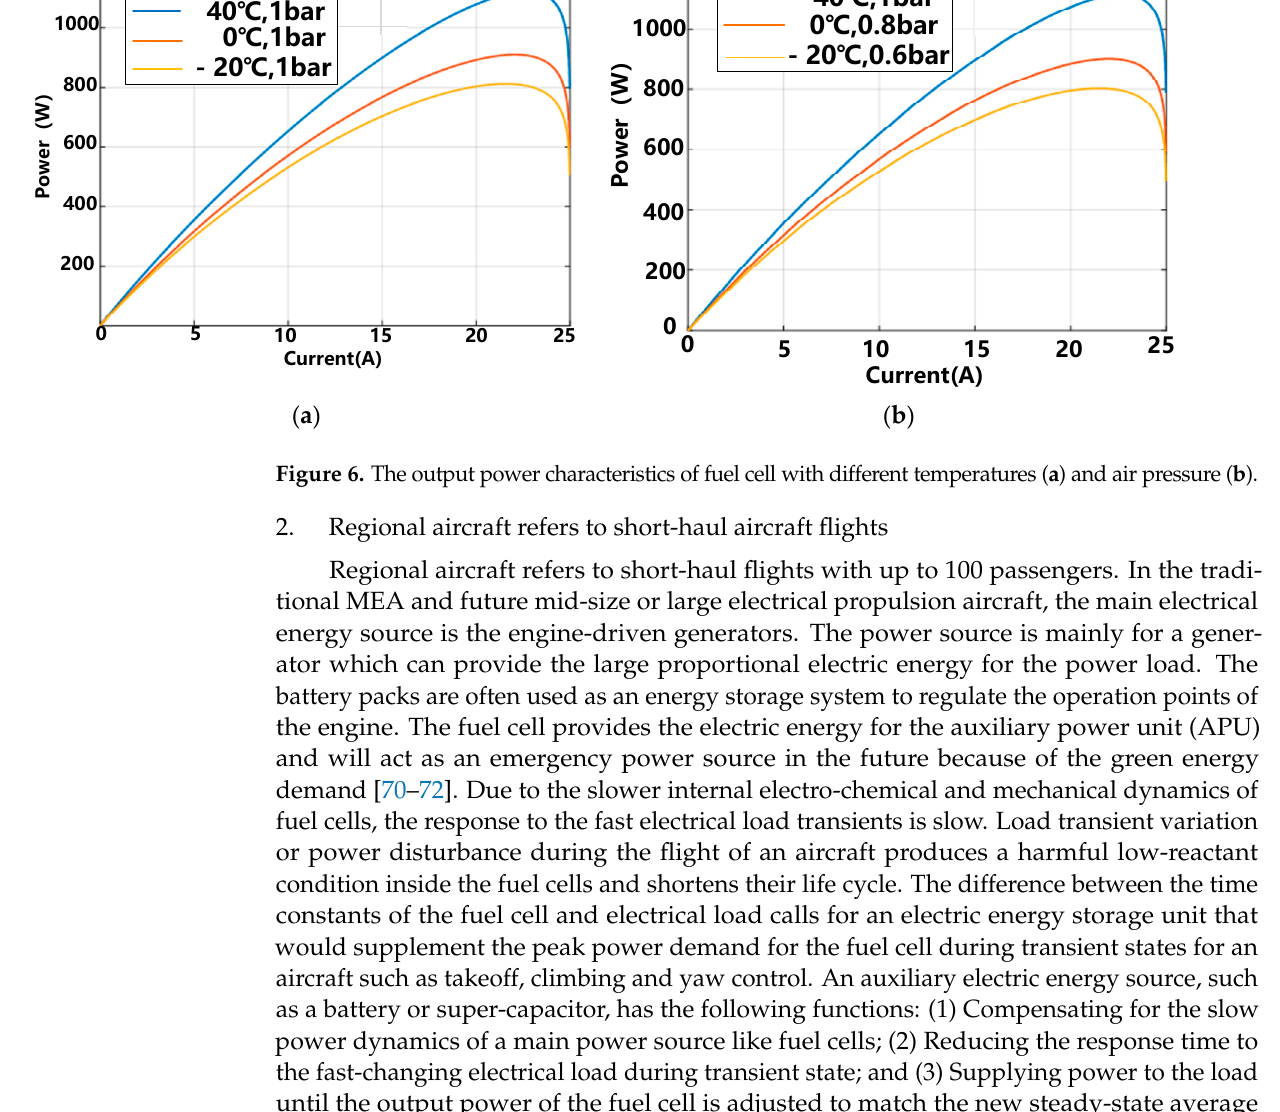
Figure 5. The power characteristics of PV modules under different ambient temperatures ( a ) and solar irradiance ( b ).